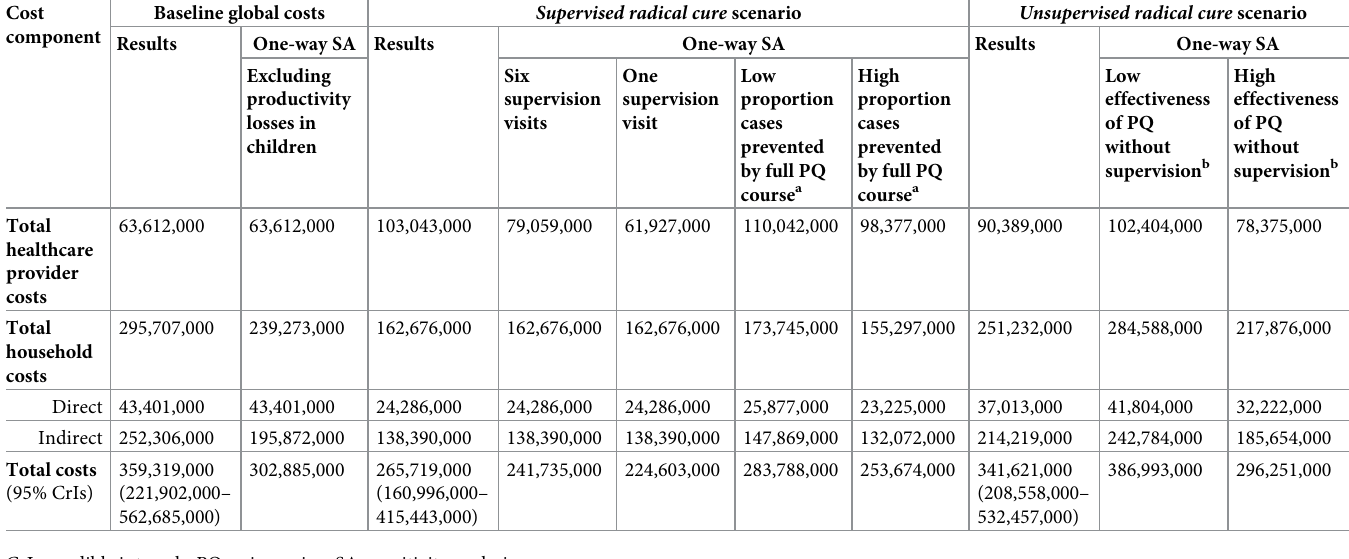
Table 3. Results of the baseline global costs and Supervised radical cure and Unsupervised radical cure scenarios with 95% credible intervals for the baseline total cost estimates. One-way sensitivity analyses to 6 visits and 1 visit of supervision as compared to 13 visits. All costs are in 2017 United States Dollars and rounded to the nearest